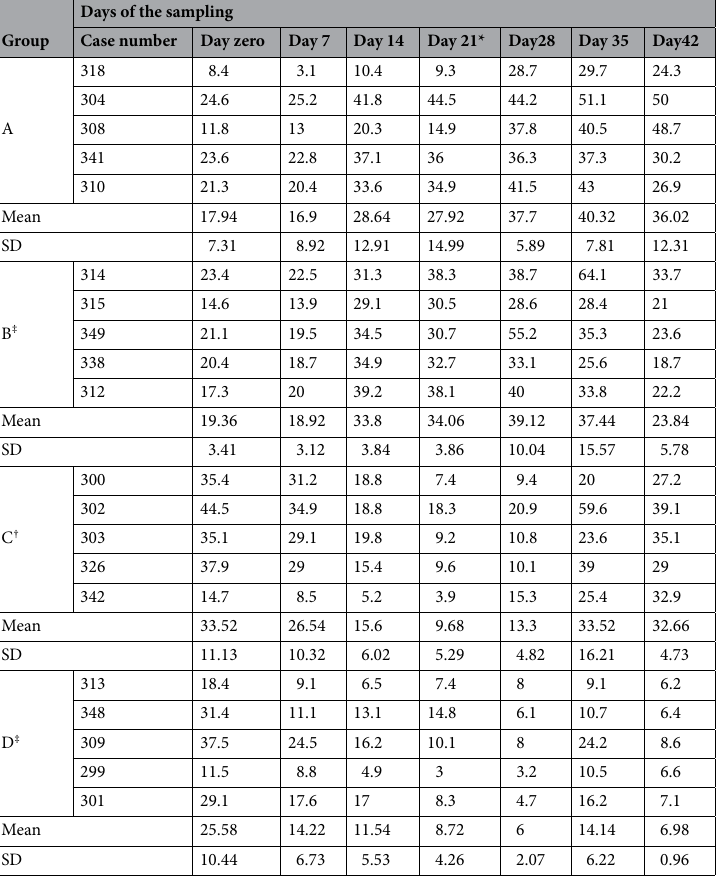
Table 1. The amount of 25D 3 (ng/mL) in each calf and Mean ± SD of variations of 25D 3 (ng/mL) in all groups. Groups A and B: were free to choose sun or shade. Group C and D: were restricted in the completely dark barn. Number of cases = The number of ear plaque of examined calves. SD = Standard Deviation of Mean. The day 21 (the fourth week of the experiment) was the date when groups A and C received 11,000 IU/kg of injectable Cholecalciferol. *The mean of variations of groups A and B had significant different with groups C and D after four weeks ( P < 0.01). † The procedure of variations in the six weeks in group D was decreasing ( P < 0.01). ‡ The mean of 25D 3 in groups B and D were 36.02 and 6.98 ng/mL respectively in six weeks of experiment.